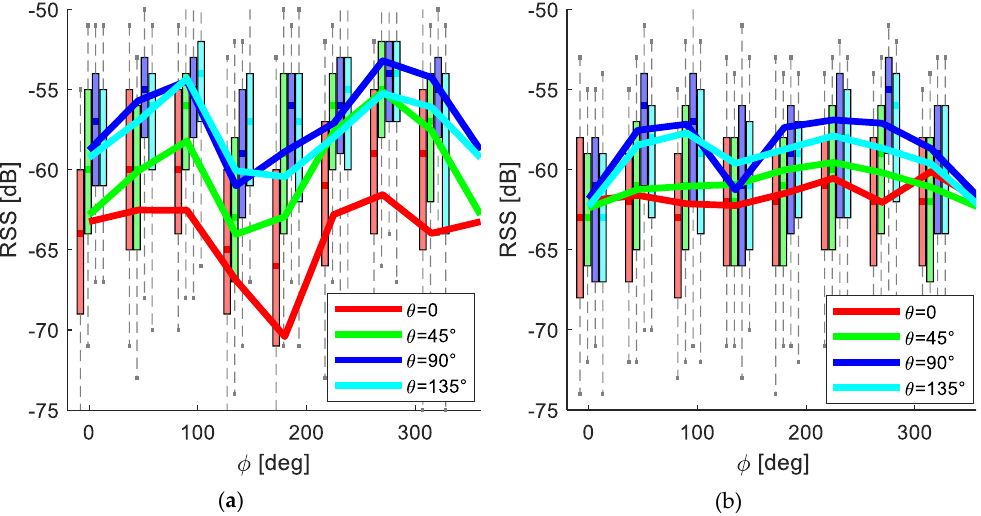
Figure 8. Results of the RSS-orientation experiment in the open space ( a ) and in the barn ( b ). The solid lines represent the average for each value of θ , and the boxplots represent the RSS deviation of the line with the corresponding color.